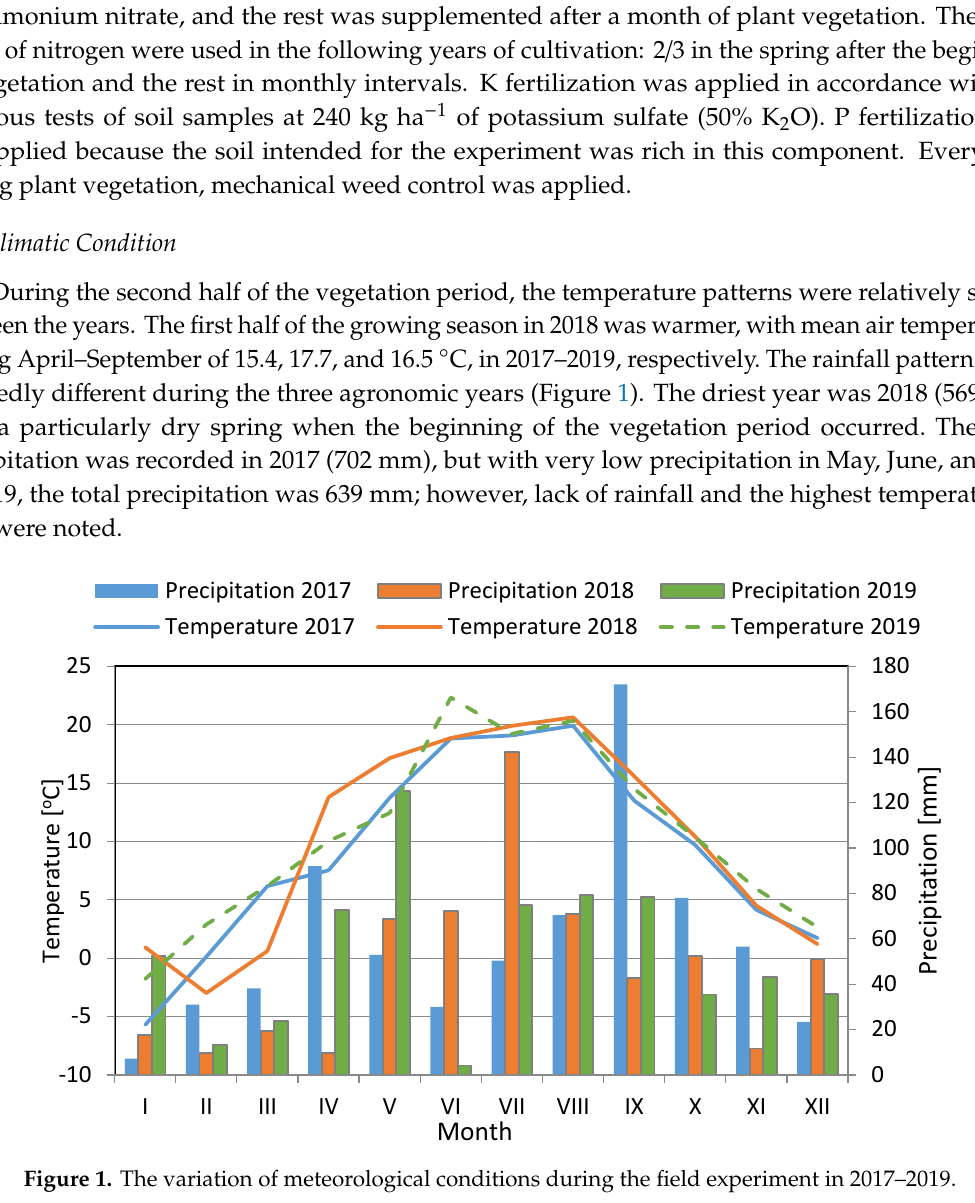
Figure 1. The variation of meteorological conditions during the field experiment in 2017 – 2019.